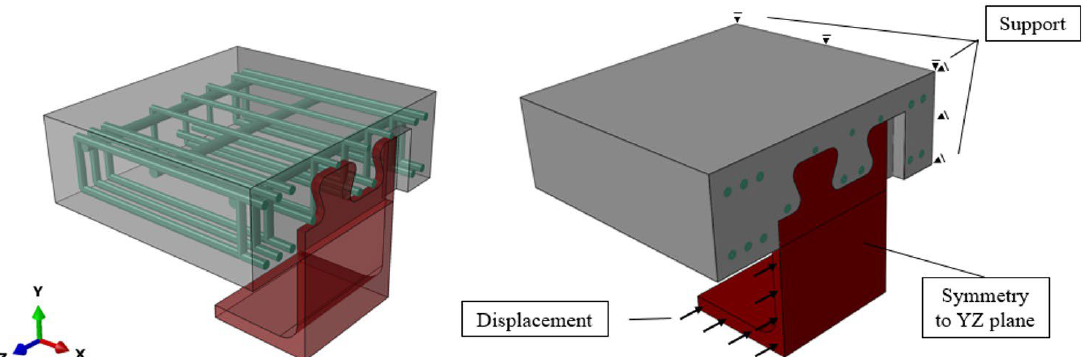
Figure 18. Numerical model developed for the parametric study.